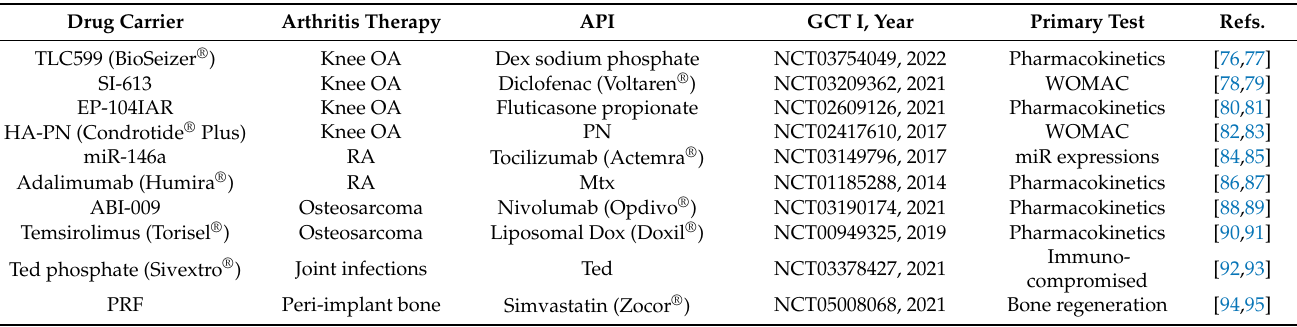
Table 1. Drug carriers for arthritis therapy, API, GCTI and year completed, and primary